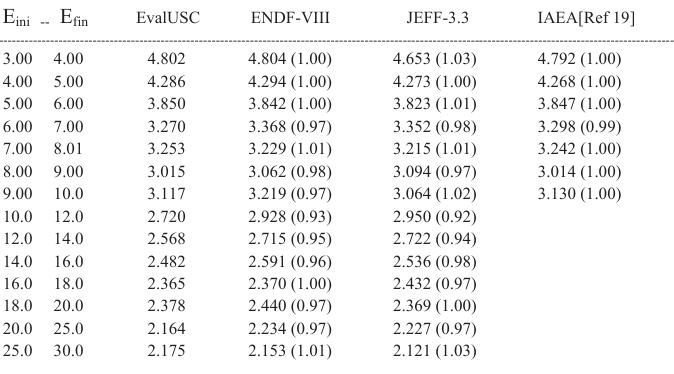
Table 2. Integral mean values compared with last evaluated libraries. E n is in keV and the cross section in barn. In brackets are the ratios of the USC-Eval to the evaluated